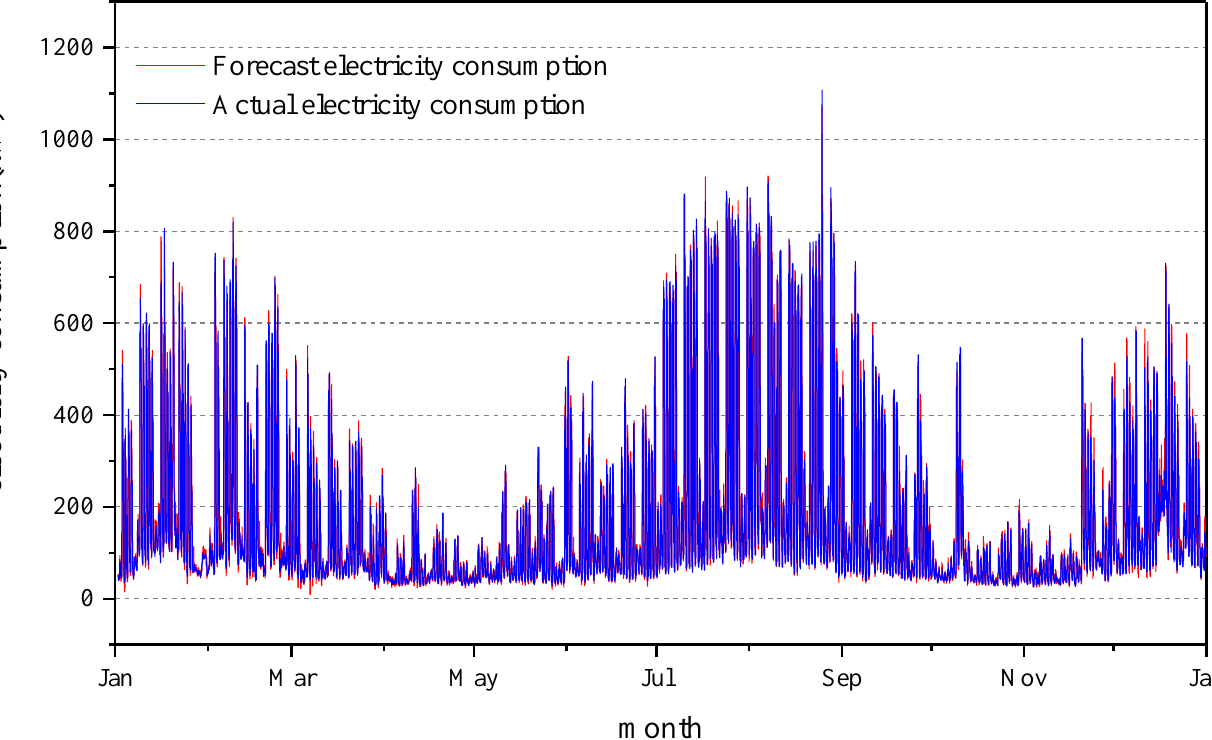
Figure 7. Hourly air-conditioning electricity forecast in 2017.